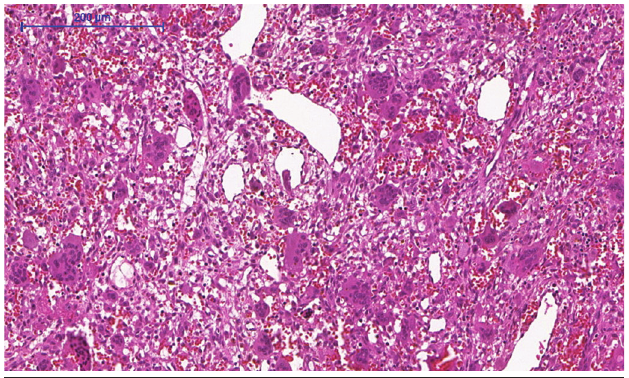
figurE 1 − Microscopic aspects of CGCG: proliferation of mononuclear mesenchymal cells associated with a population of multinucleated giant cells in a matrix of dense fibrous conjunctive tissue, presenting extravasated red blood cells (HE, 200 µm) CGCG: central giant cell granuloma; HE: hematoxylin and